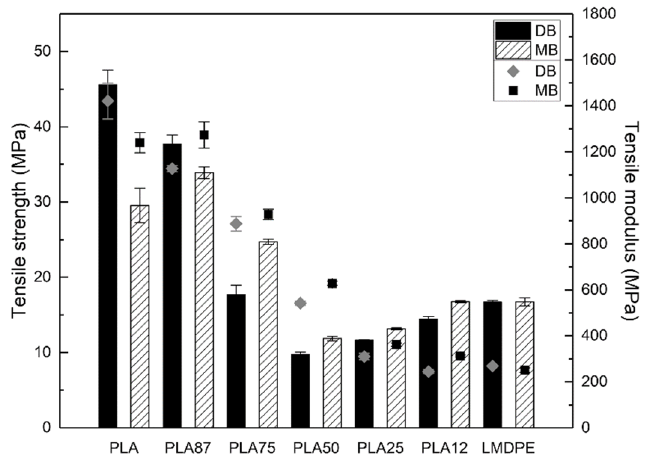
Figure 7. Tensile properties of the rotomolded parts: Strength (column bars) and modulus (closed symbols).